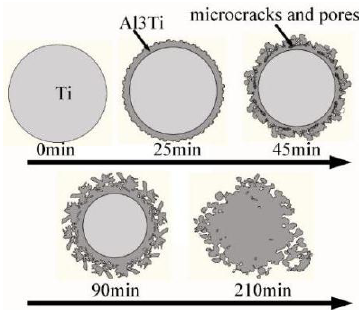
Figure 13. An illustration of the Al 3 Ti phase formation process.